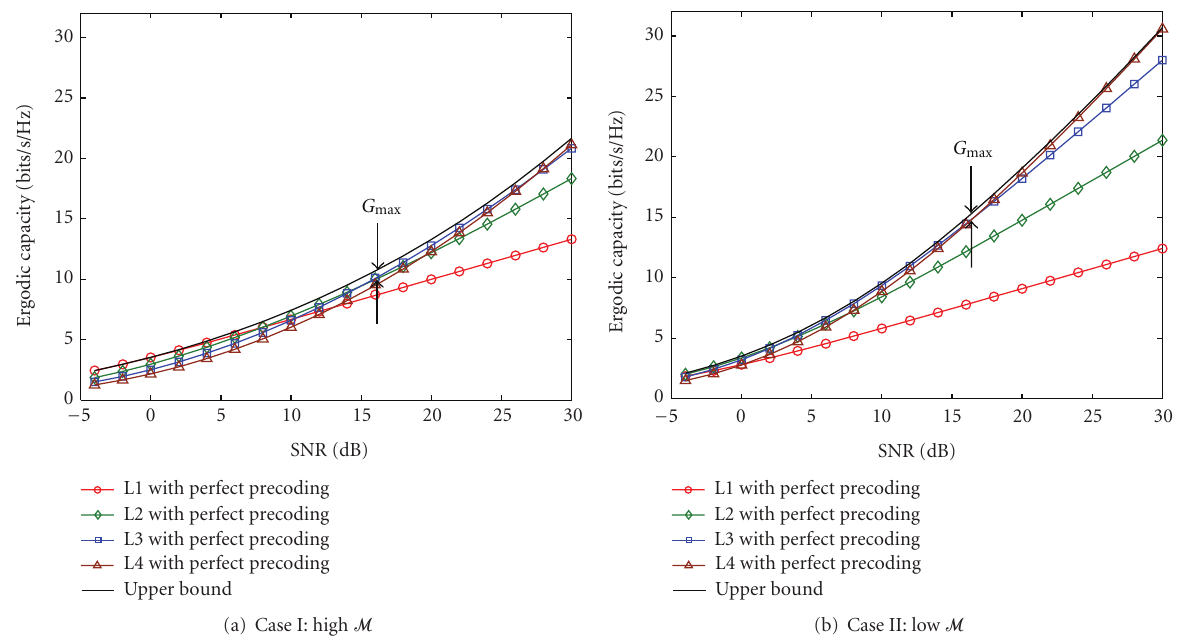
Figure 4: Capacity of di ff erent layer transmissions with perfect precoding.